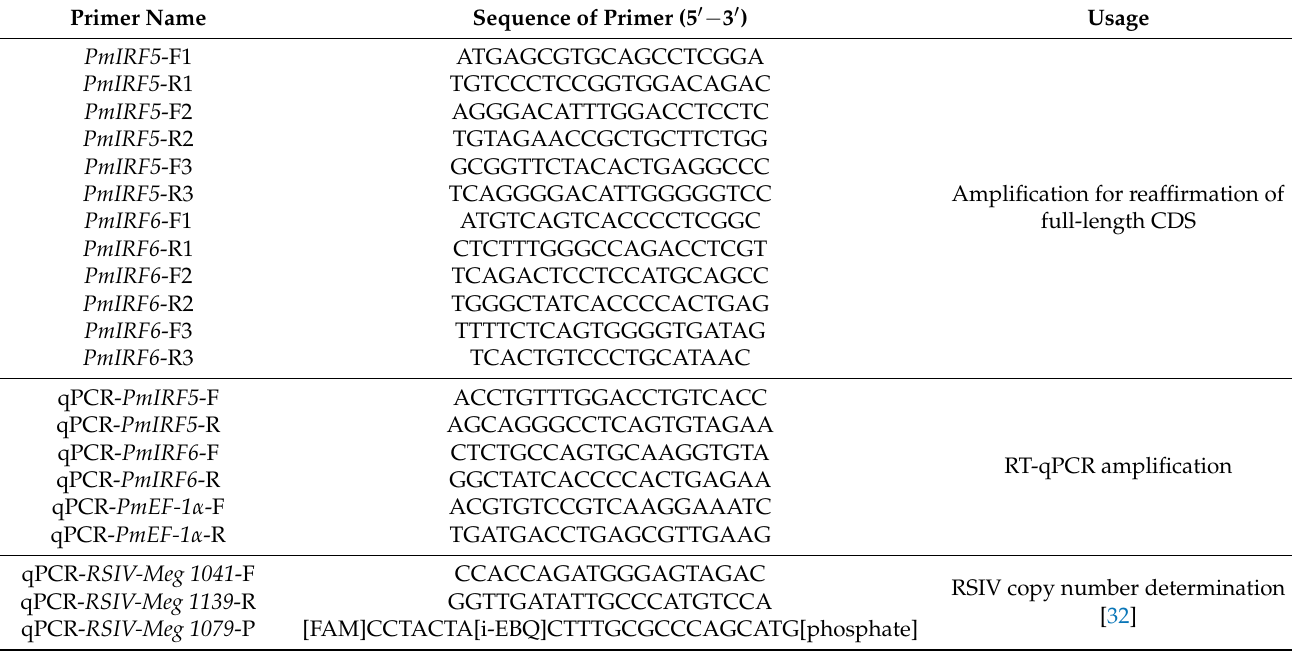
Table 1. Primer sequences used in this